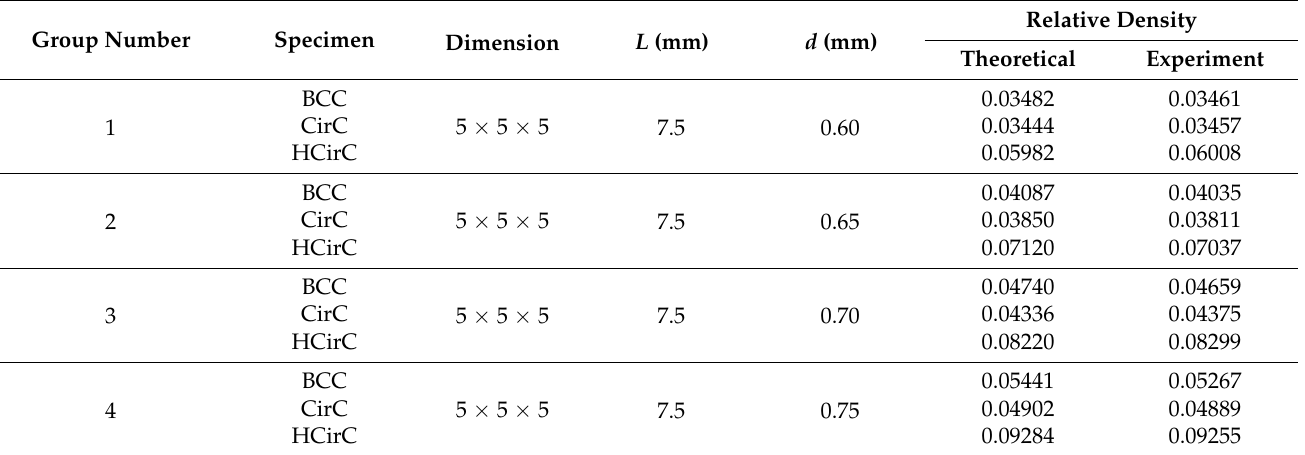
Table 1. The geometrical parameters used in 3D printing and the relative density of the fabricated lattice structures BCC, CirC, and